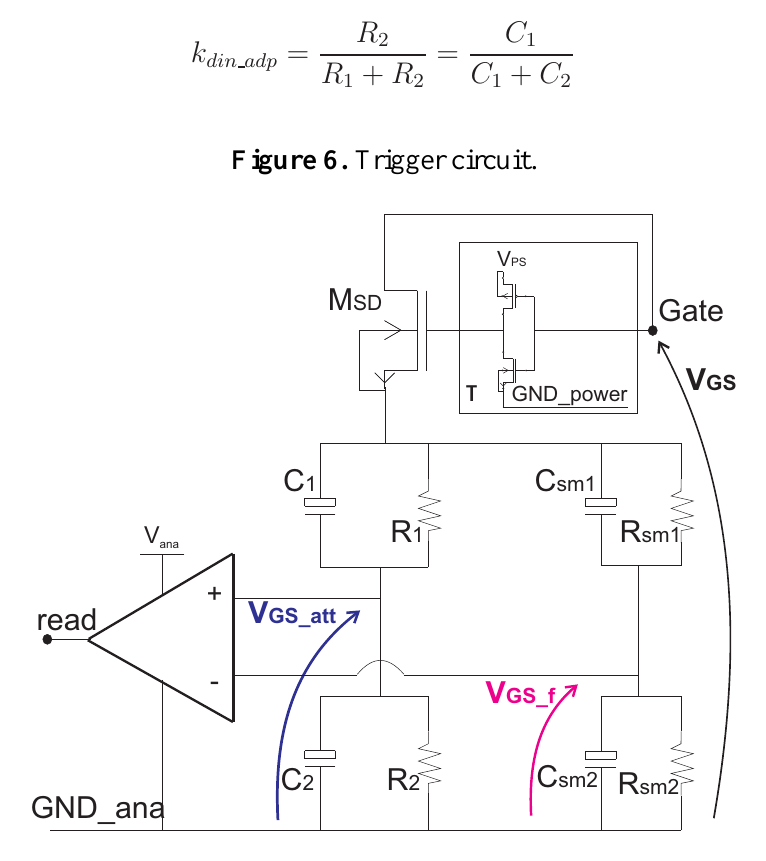
Figure 6. Trigger circuit.